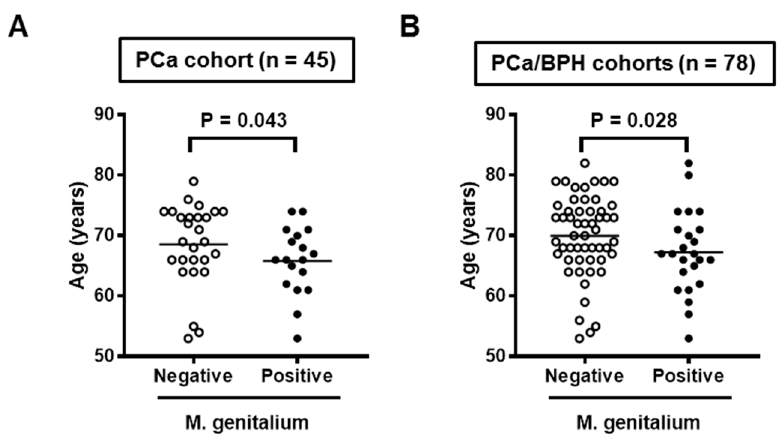
Figure 3. Association between age and Mycoplasma genitalium infection status in surgical specimens. Data for patient age at surgery for the Mycoplasma genitalium -positive group and negative group are shown as scatterplots in the analysis of the PCa cohort ( A ) and the PCa/BPH cohort ( B ). Mann–Whitney U-test was used to compare the two groups.